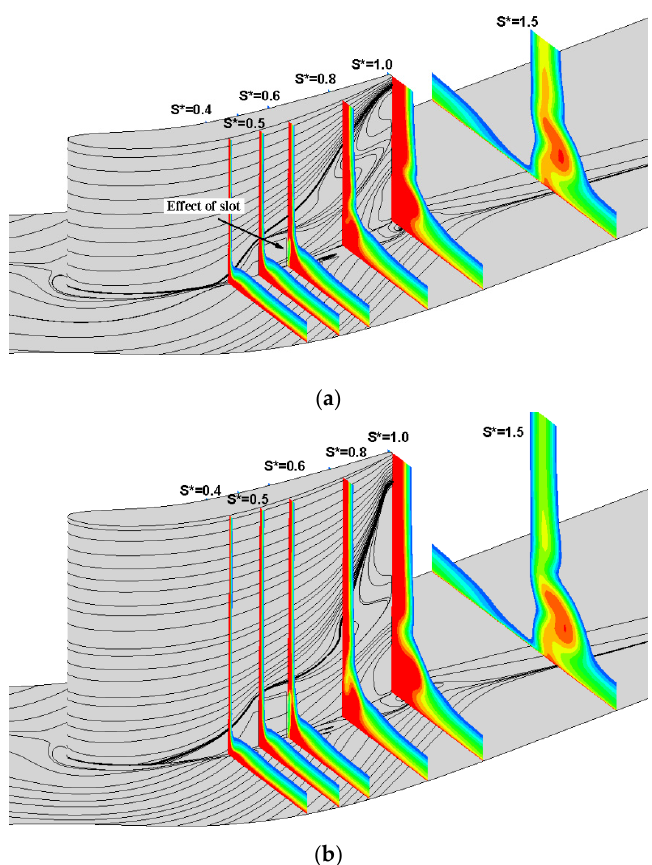
Figure 11. Influence of aspect ratio combined with the slot on limiting streamlines and the passage total pressure loss coefficient at the i = 3° incidence angle: ( a ) slot, h/c = 1; and ( b ) slot, h/c =